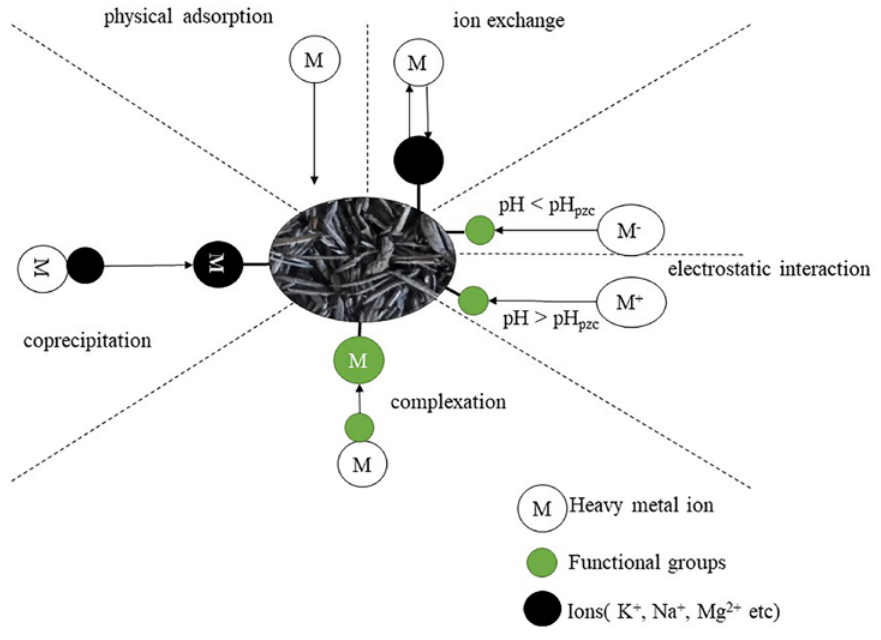
Figure 2. Removal mechanisms for rice husk biochar.